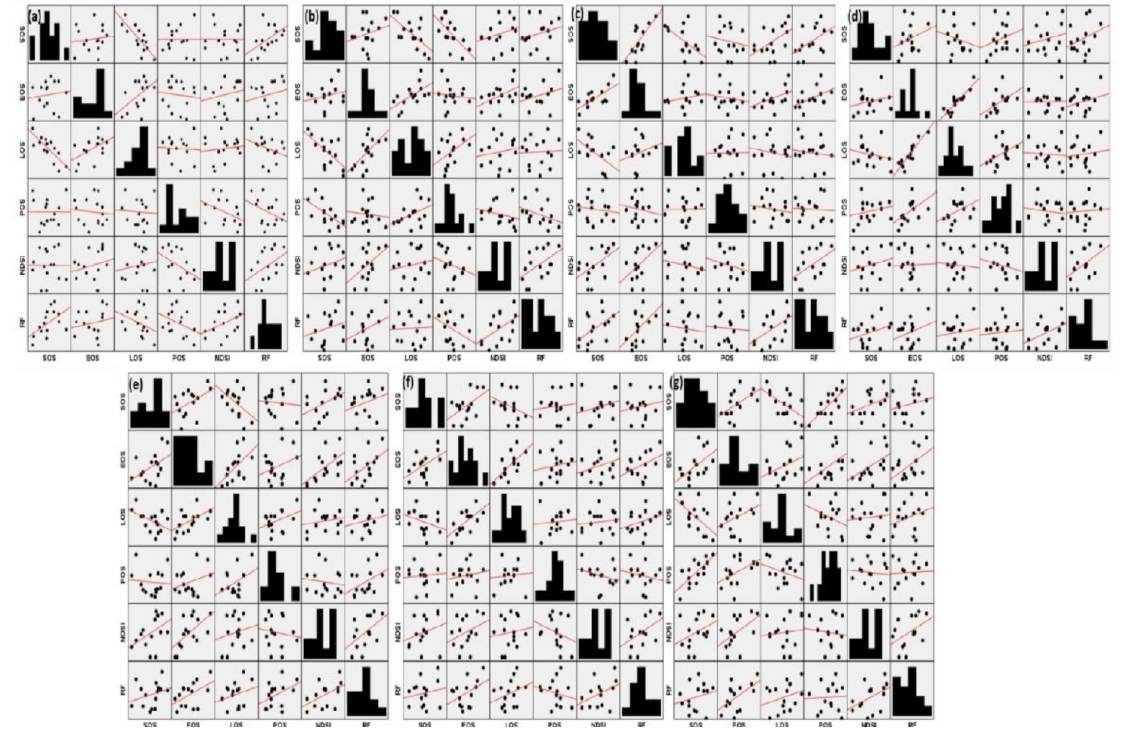
Figure 7. Correlation between seasonality parameters, seasonal NDSI, and Rainfall in the selected apple orchard